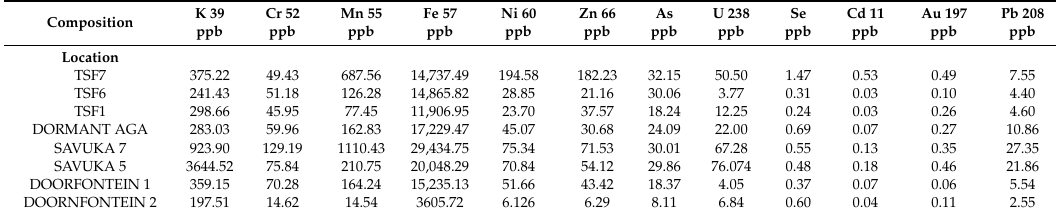
Table A5. ICP-MS results for tailings storage facilities.